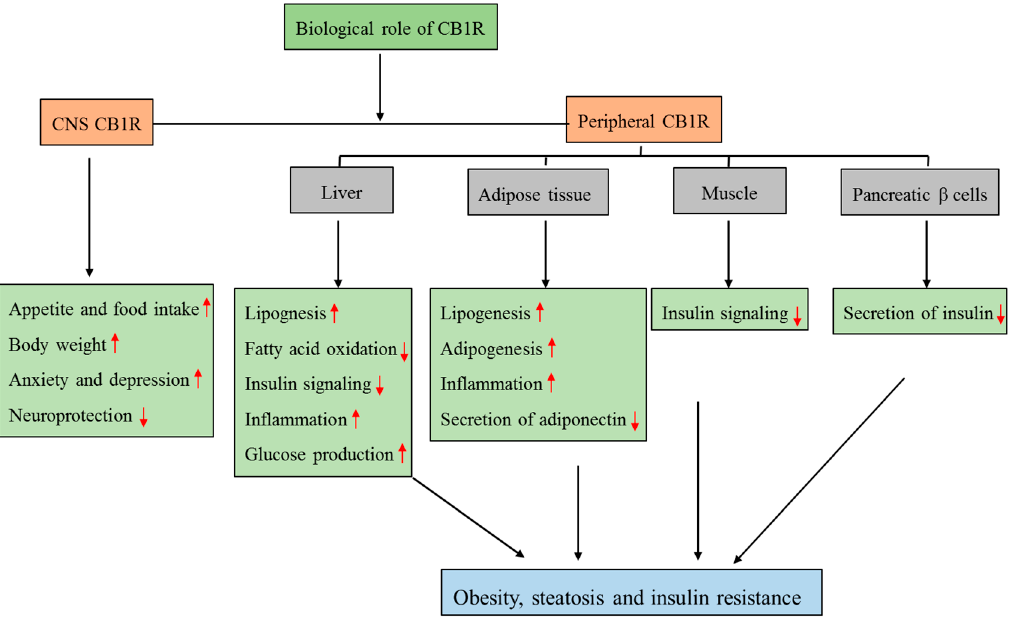
Figure 2. Biological role of CNS and peripheral CB1R in relation to obesity and insulin resistance. The localization of CB1R in the peripheral tissues such as liver, adipose tissue, muscle, and pancreatic β -cells has a potential role in obesity and related metabolic disorders without causing any adverse effects on the central nervous system. (Up arrow denotes increase and down arrow denotes decrease).